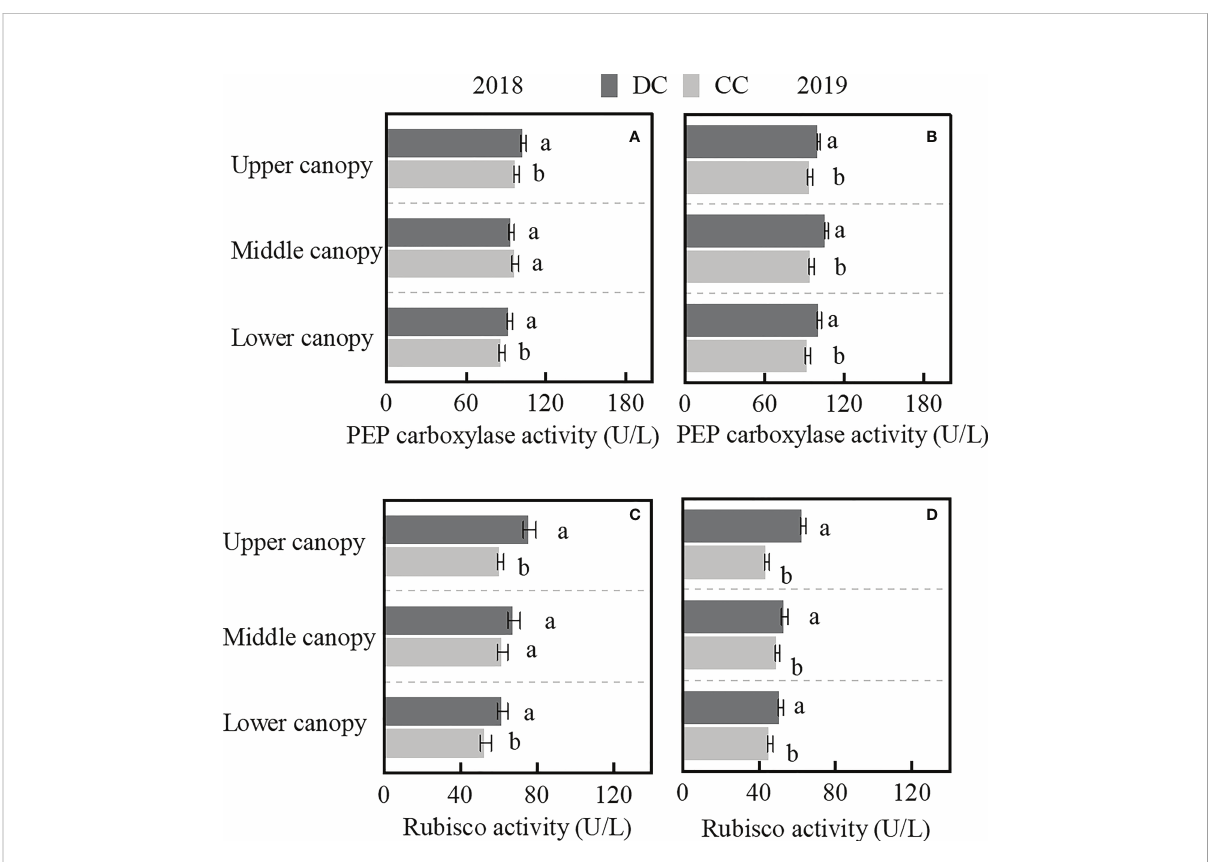
FIGURE 6 Activities of PEP carboxylase and Rubisco in the different canopy leaves at the R1 stage. (A, B) : PEP carboxylase activity of upper, middle, and lower canopy leaves in 2018 and 2019. (C, D) : Rubisco activity of differences canopy leaves in 2018 and 2019. DC, Dense cultivation. CC, Common cultivation. Different letters denote signi fi cant differences ( P < 0.05), error bars show standard error of the mean.